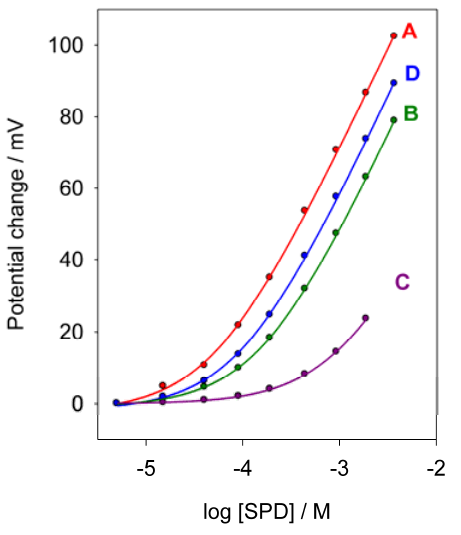
Figure 3. Calibration graphs of sulpiride obtained with the membranes A, B, C,